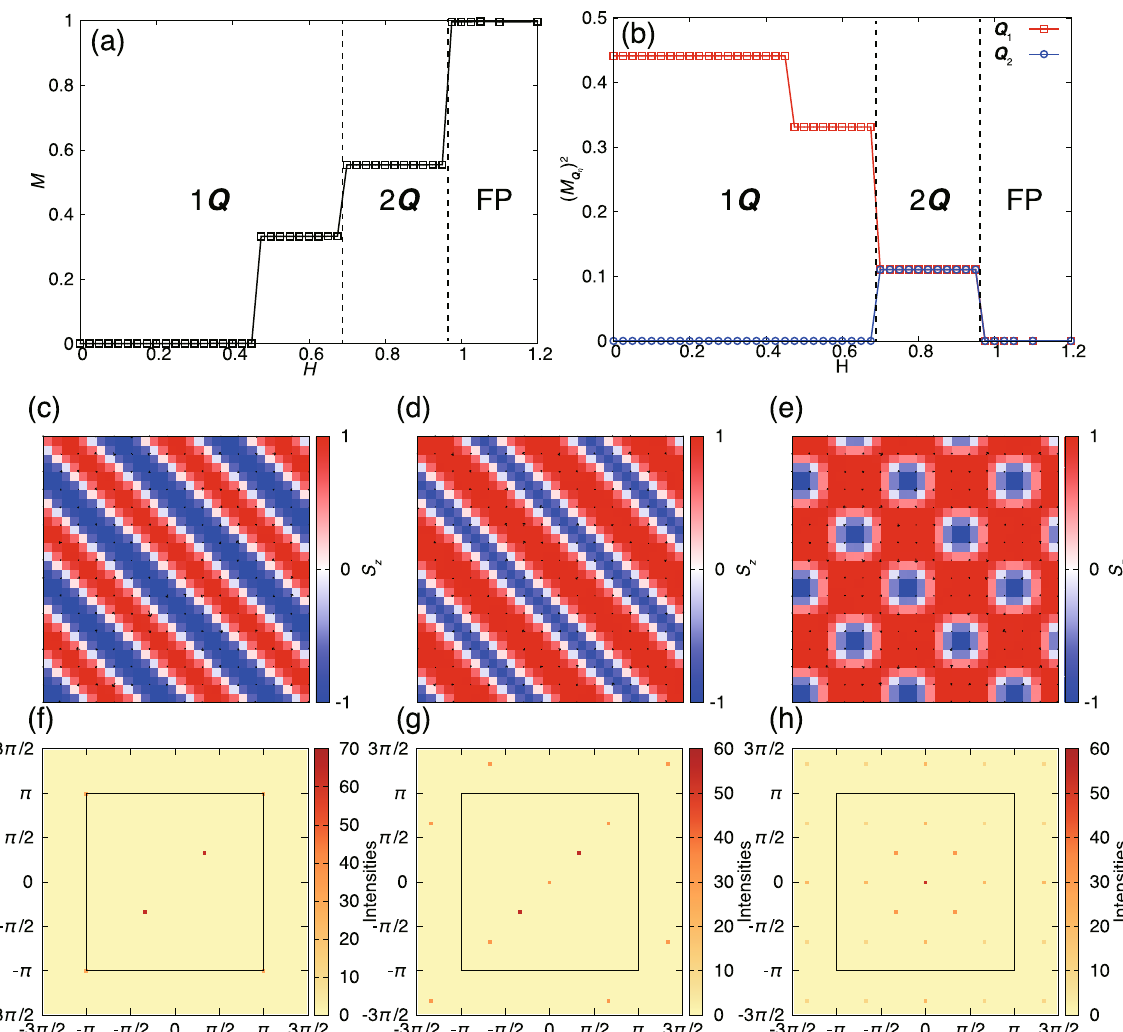
Fig. 3 Magnetization and spin con fi gurations of CeAuSb 2 . H dependences of the magnetization for a uniform component, and b Q 1 (squares) and Q 2 (circles) components at ~ J ¼ 1, K = 0.4, and A = 0.7. The vertical dashed lines show the phase boundaries. c – e The real-space spin con fi gurations in c the 1 Q collinear state at H = 0, d the 1 Q collinear state at H = 0.6, and e the 2 Q bubble state at H = 0.8. The contour shows the z -component of the spin moment. f – h The square root of the spin structure factor. The solid squares represent the Brillouin